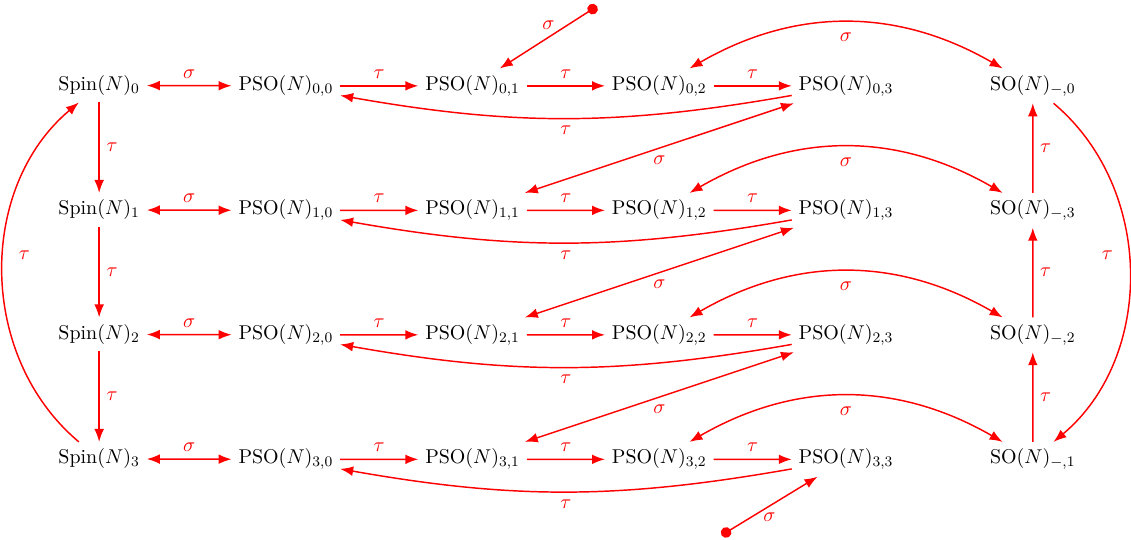
Figure 8 . Web of transformations (quotiented by charge conjugation) for theories with gauge algebra so (4 k + 2) . Here τ represents coupling to an invertible phase, while σ corresponds to gauging the Z 4 center symmetry. Note that Spin( N ) m represents Spin( N ) coupled to m copies of the primitive invertible phase, and likewise for the other